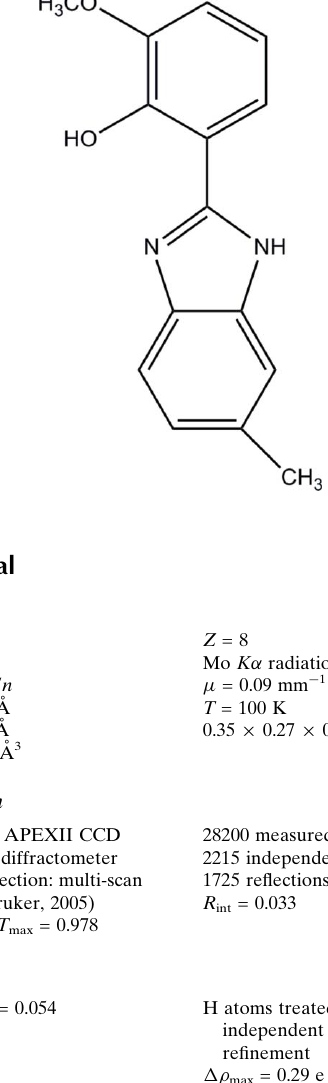
Bruker SMART APEXII CCD area-detector diffractometer Absorption correction: multi-scan ( SADABS ; Bruker, 2005) T min = 0.969, T max = 0.978